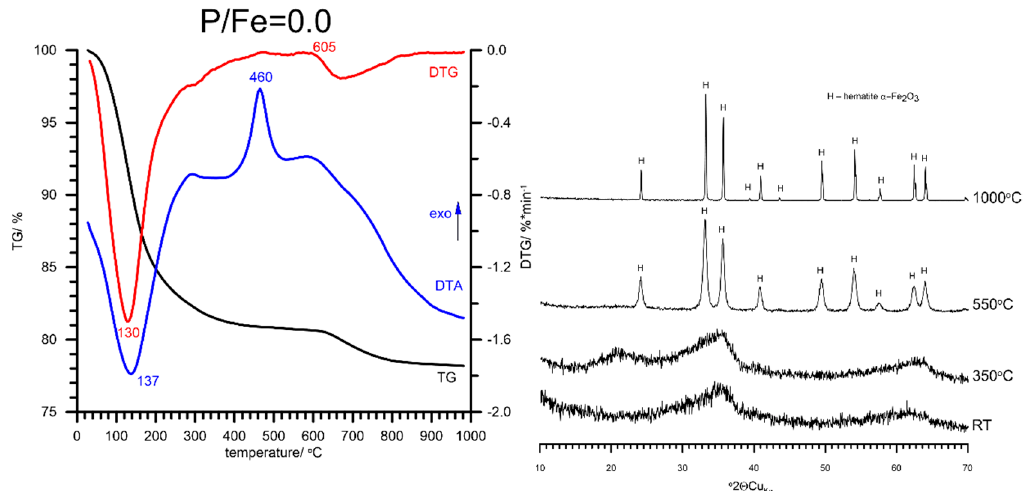
Figure 4. The results of thermal analysis and relevant XRD patterns of pure synthetic ferrihydrite and products of its thermal transformations at various temperatures. The formation of hematite ( α -Fe 2 O 3 ) at 460 °C, which remains stable up to 1000 °C, is apparent. No intermediate phase was detected. RT—room temperature.